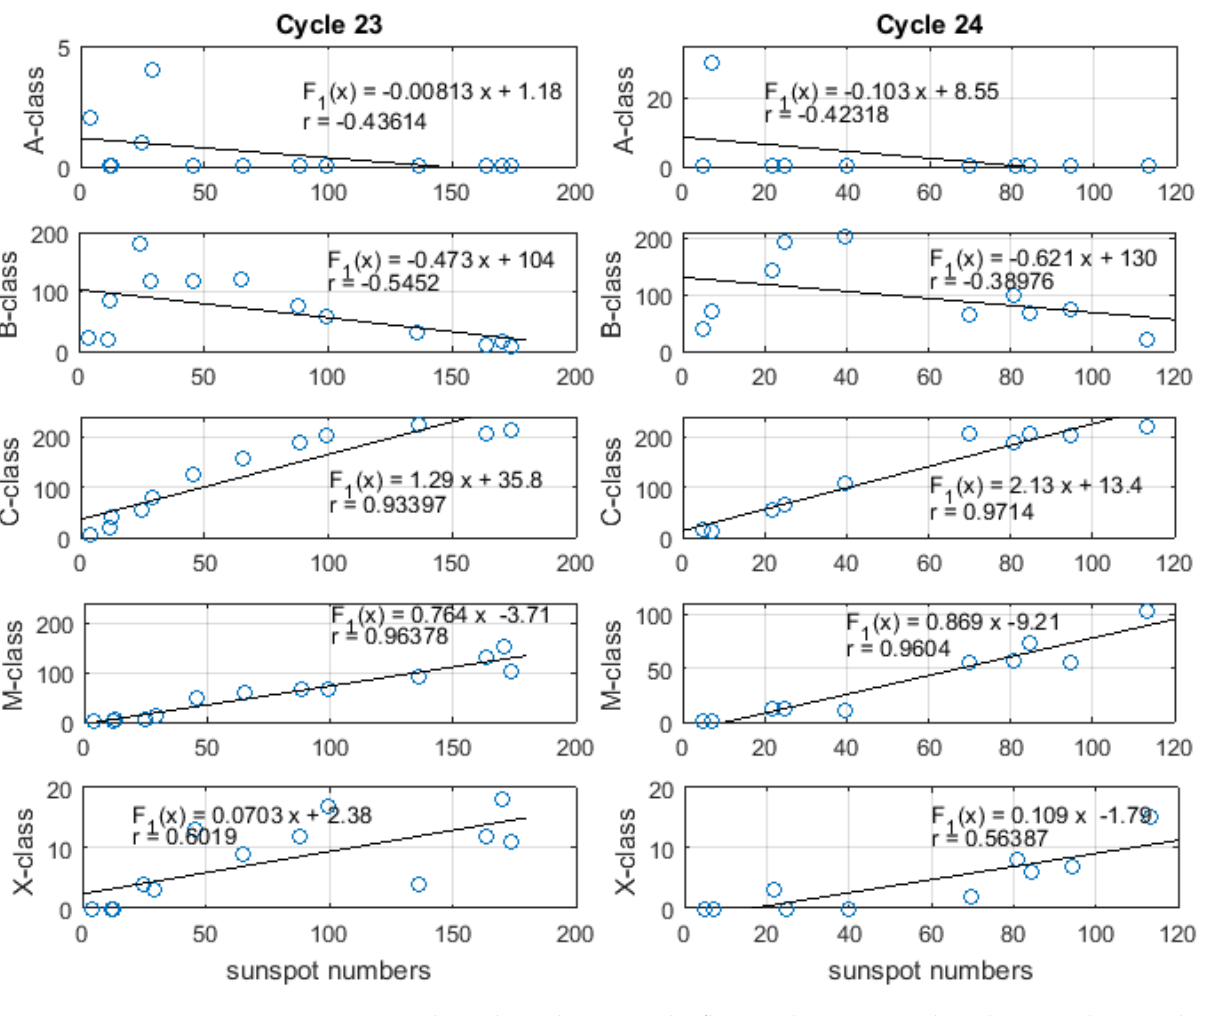
Figure 3. Annual correlation between solar flares and sunspot numbers during cycles 23 and 24.